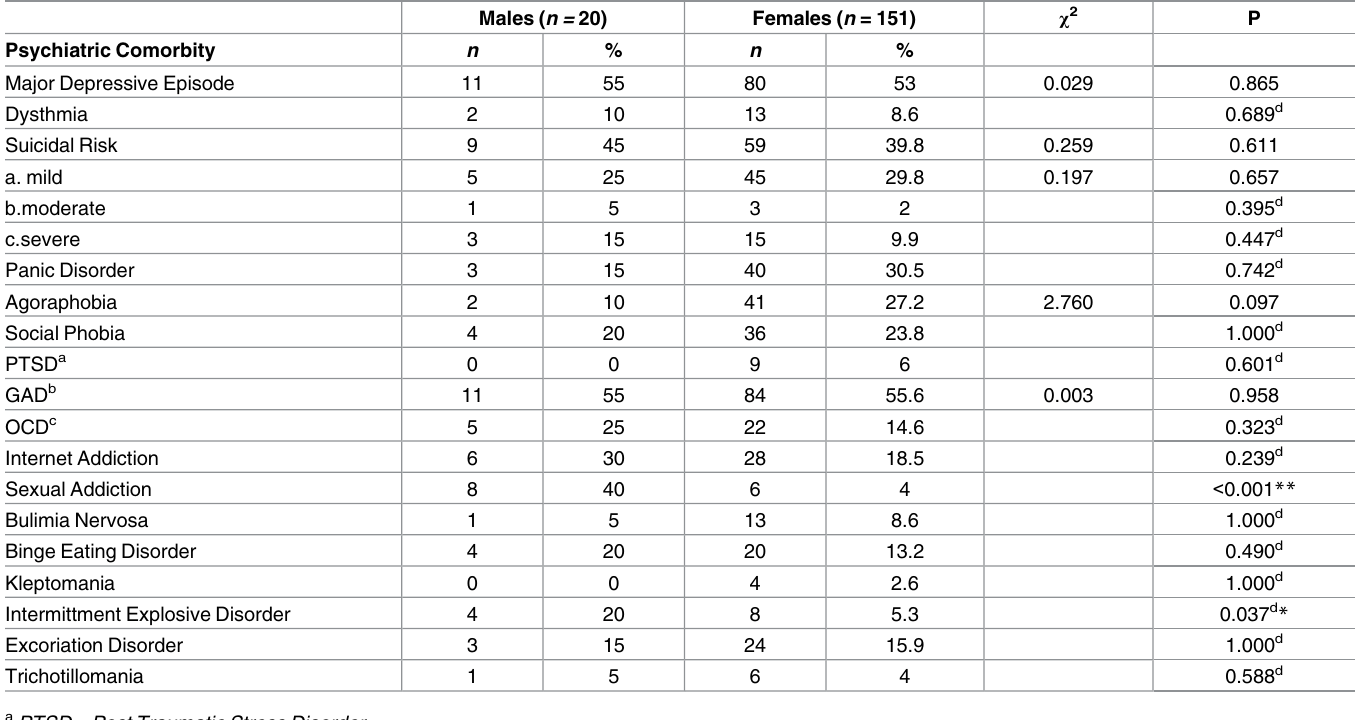
Table 2. Psychiatric co-morbdity and gender diferences in compulsive